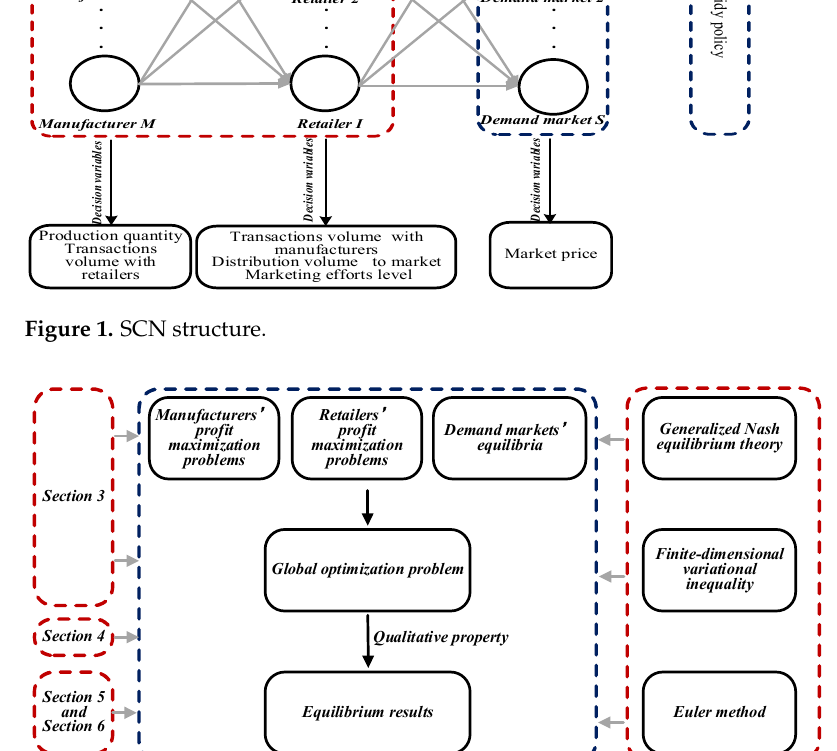
Figure 2. Roadmap. Figure 2. Table 1. Symbol description. Symbol Description